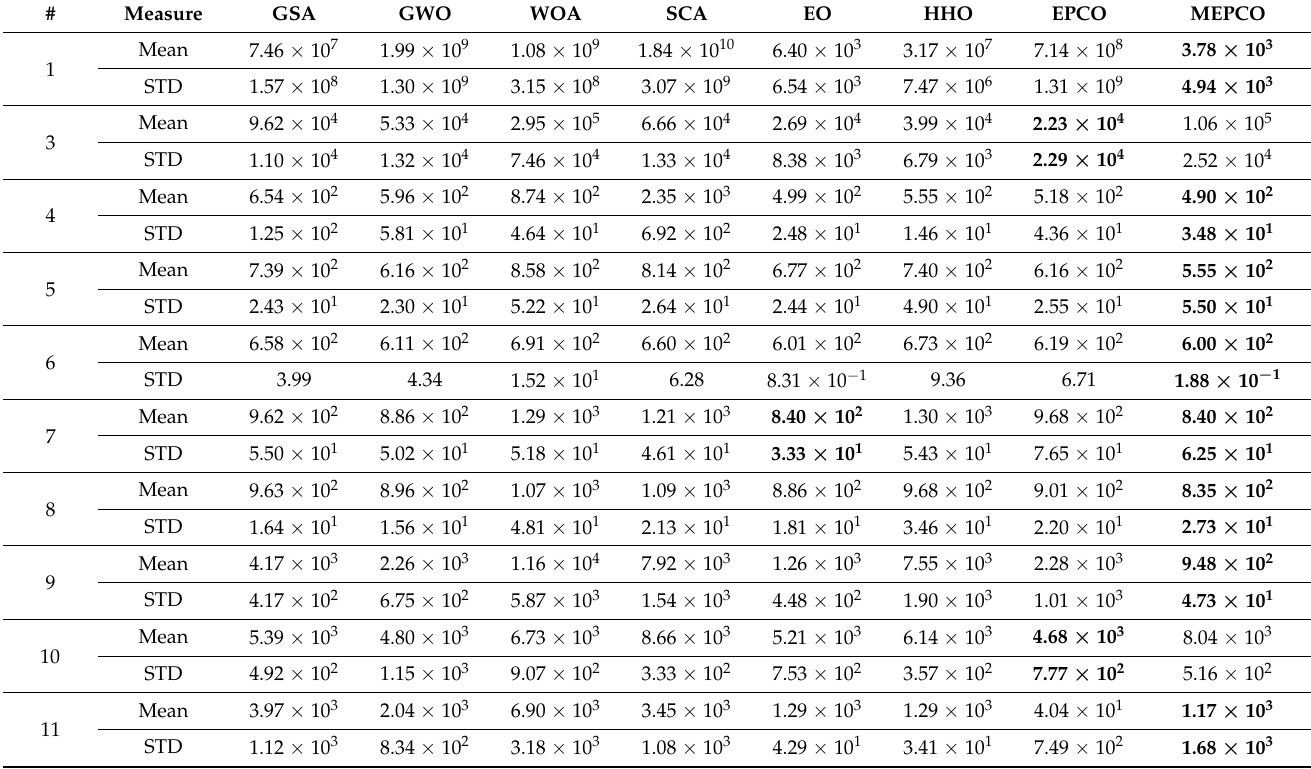
Table 3. The mean and STD of optimal values of the OF for thirty trials achieved with the various techniques on the CEC’17 benchmark with dimension =